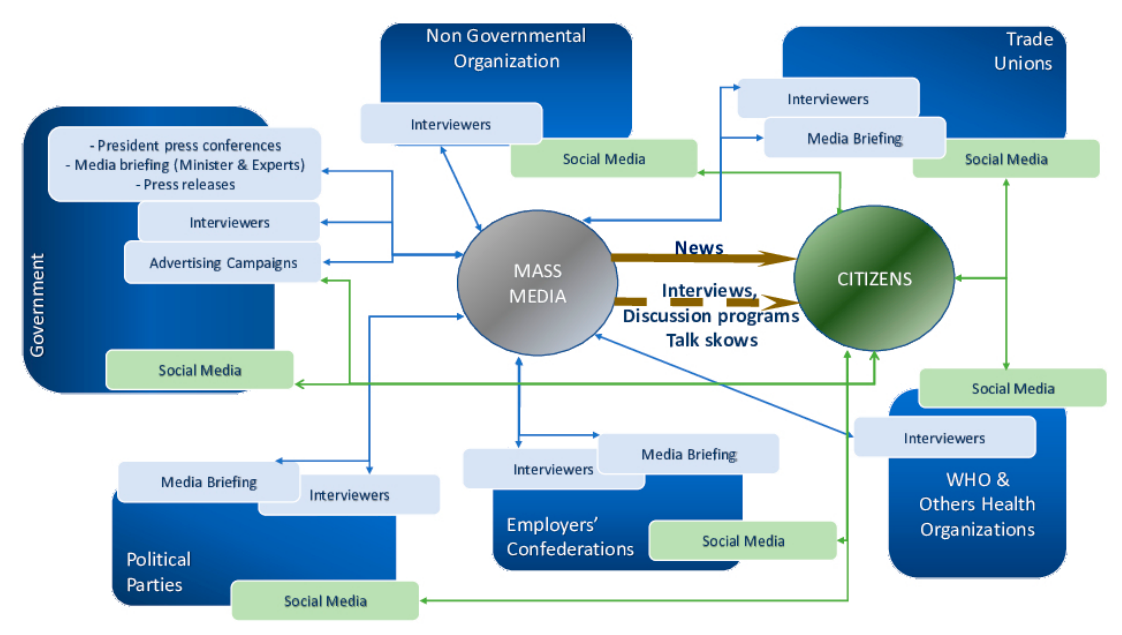
Figure 3. Interrelations between the main stakeholders and the citizens .